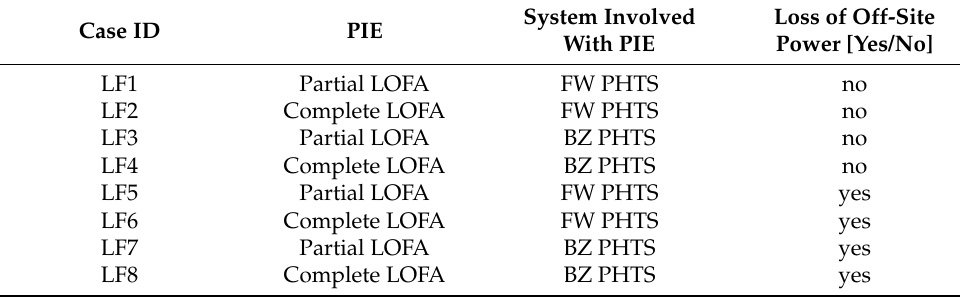
Table 5. Matrix of transient simulations